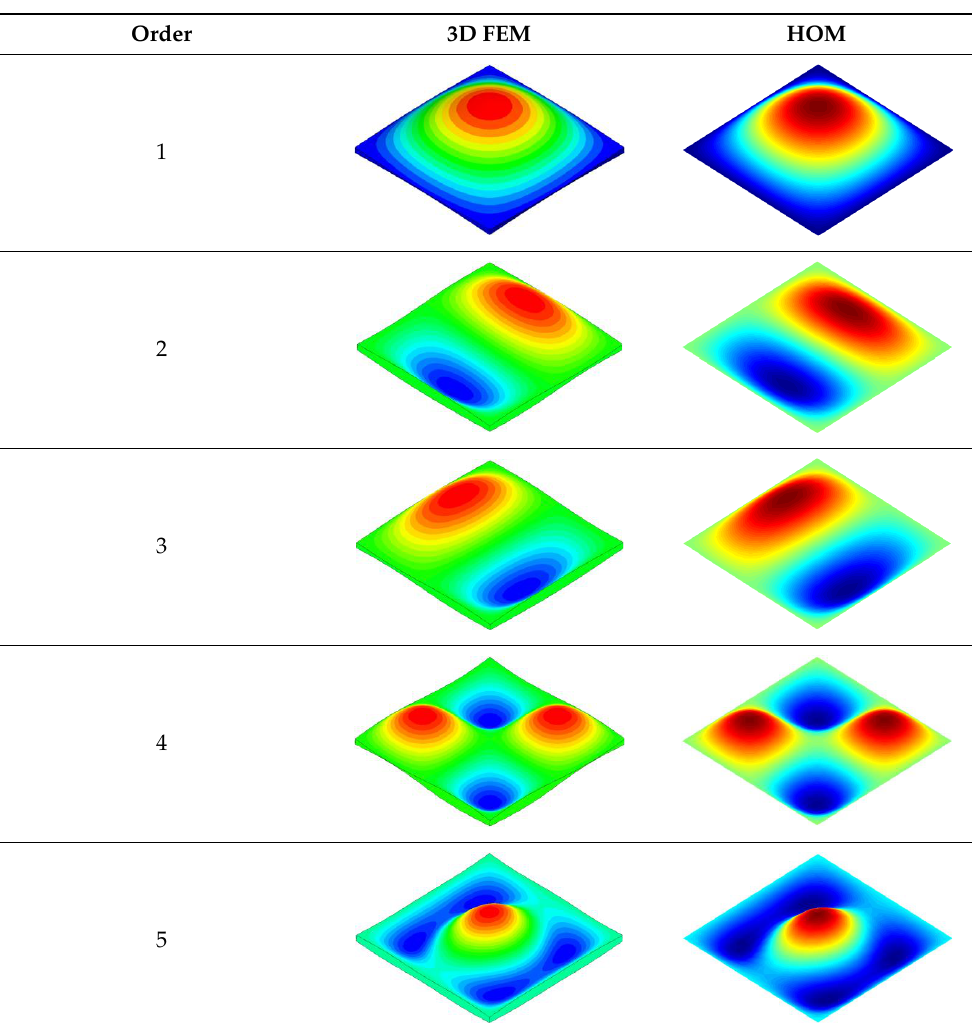
Table 3. First five-order natural frequencies of the SSSS four-layer periodic plate.